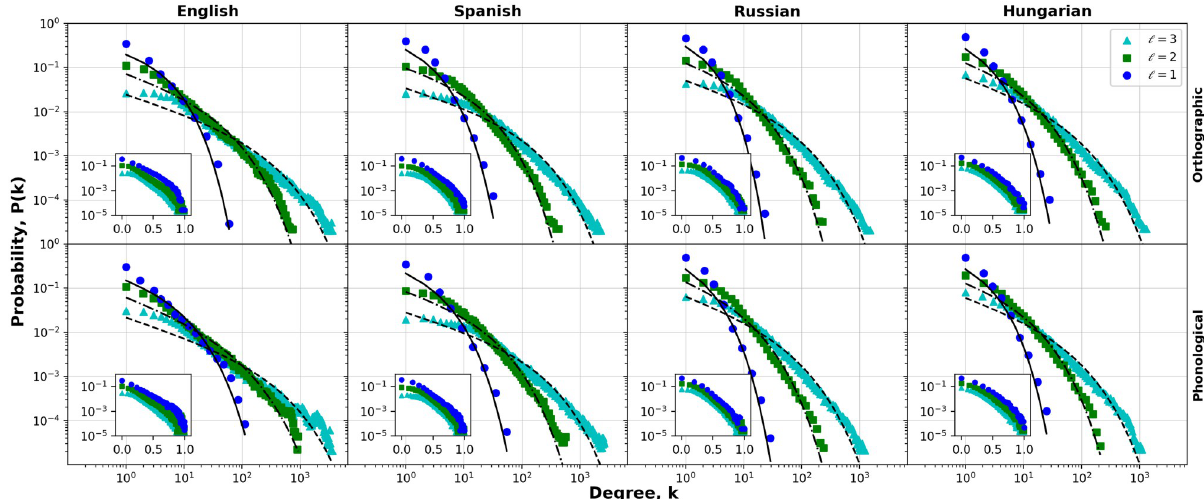
Fig 3. Degree distributions for phonological and orthographic networks. The cases of English, Spanish, Russian and Hungarian are depicted for three distance thresholds. The top row shows the distributions of the orthographic layer, while the bottom row shows the phonological layer. Dashed lines represent a Weibull-type function fit (see Table 4 in Supplementary Material at FigShare [44]). We find that for the majority of languages and both layers, the distributions display a heavy-tailed behavior. For a better comparison of the data, the insets of each plot show the corresponding degree distribution for normalized degrees k / k � (horizontal axis), where k � = max(log( k )).